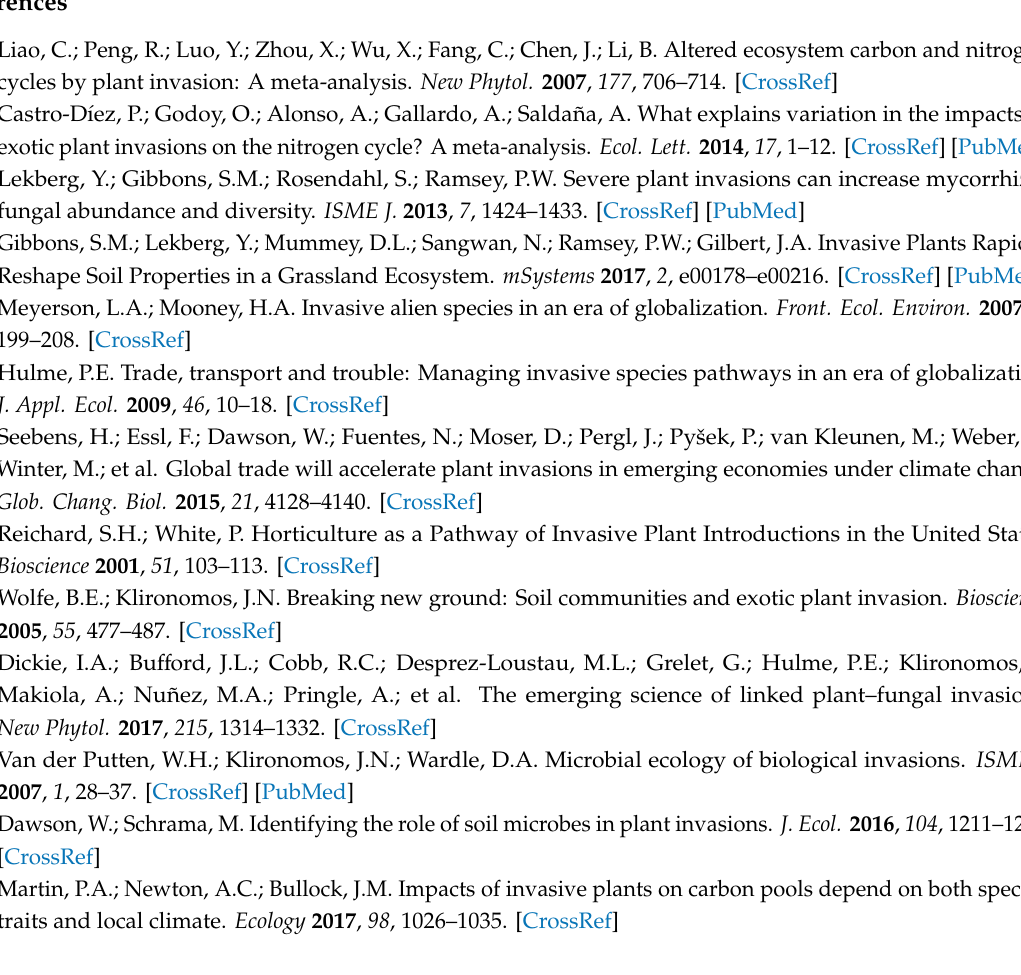
Supplementary Table S1: Studies used for fungal meta-analysis. Supplementary Table S2: Studies used for bacterial meta-analysis. Supplementary Table S3: Fungal model outputs and number of studies used for each model. Supplementary Table S4: Bacterial model outputs and number of studies used for each